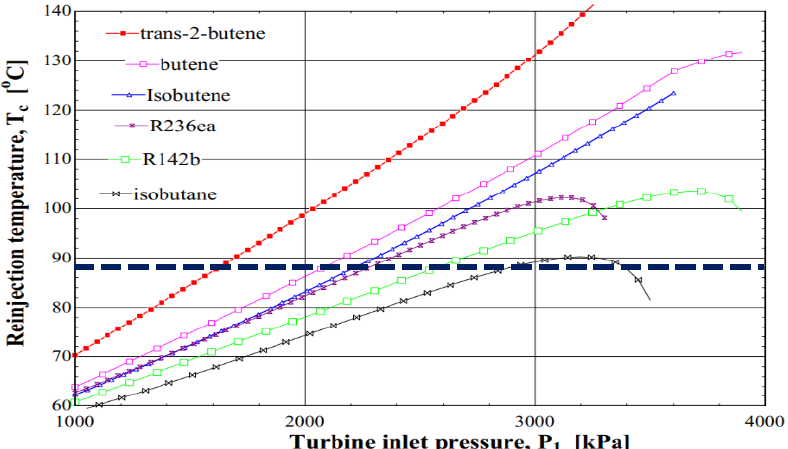
Figure 6. Variation of turbine inlet pressure with reinjection temperatures of brine for the simple ORC. The highest reinjection temperature was noted to be for trans-2-butene at 89.05.